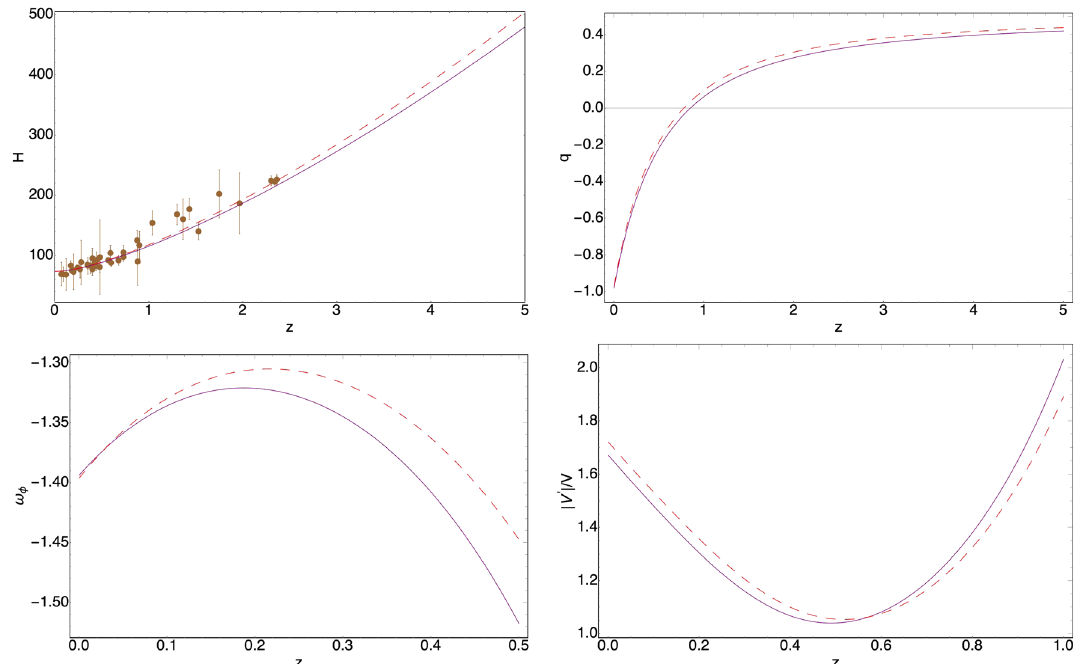
Fig. 4 A graphic behavior of the Hubble parameter, compared with known H ( z ) data presented in Table 1, is depicted on the left hand side plot of the top panel. The behavior of the deceleration parameter is rep- resented on the right hand side. The left hand side plot of the bottom panel corresponds to the behavior of the ω φ = P φ /ρ φ equation of state parameter describing the scalar field dark energy model. Further, the right hand side plot of the bottom panel shows the graphic behavior of SC2, Eq. (2). In all cases, the purple curve is the plot for the best fit val- ues of the parameters of the model, when z ∈ [ 0 , 2 . 5 ] ; while the dashed